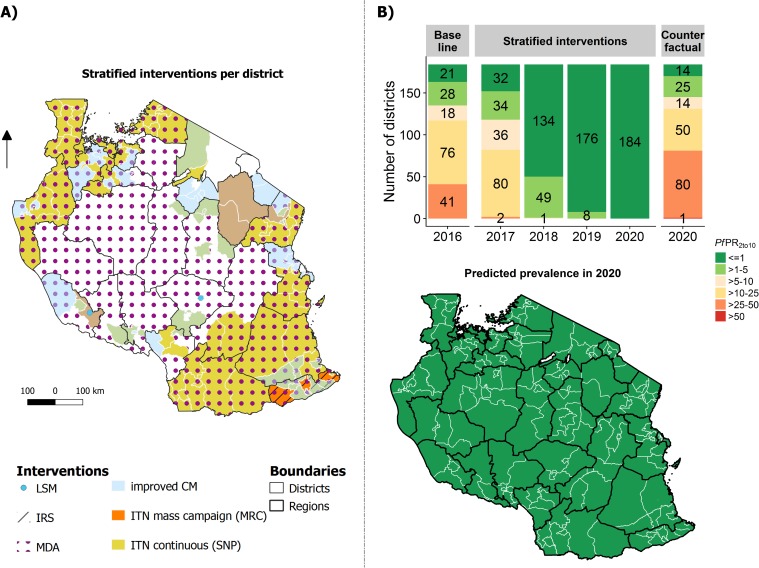
Strategy according to the selection of cost-minimised interventions that lead to the NSMP target (Strategy 3).(A) Allocation of interventions per council. (B) Predicted prevalence per council in 2020 shown in the map and number of councils per simulated endemic group for 2017–2020 shown in the bar chart.